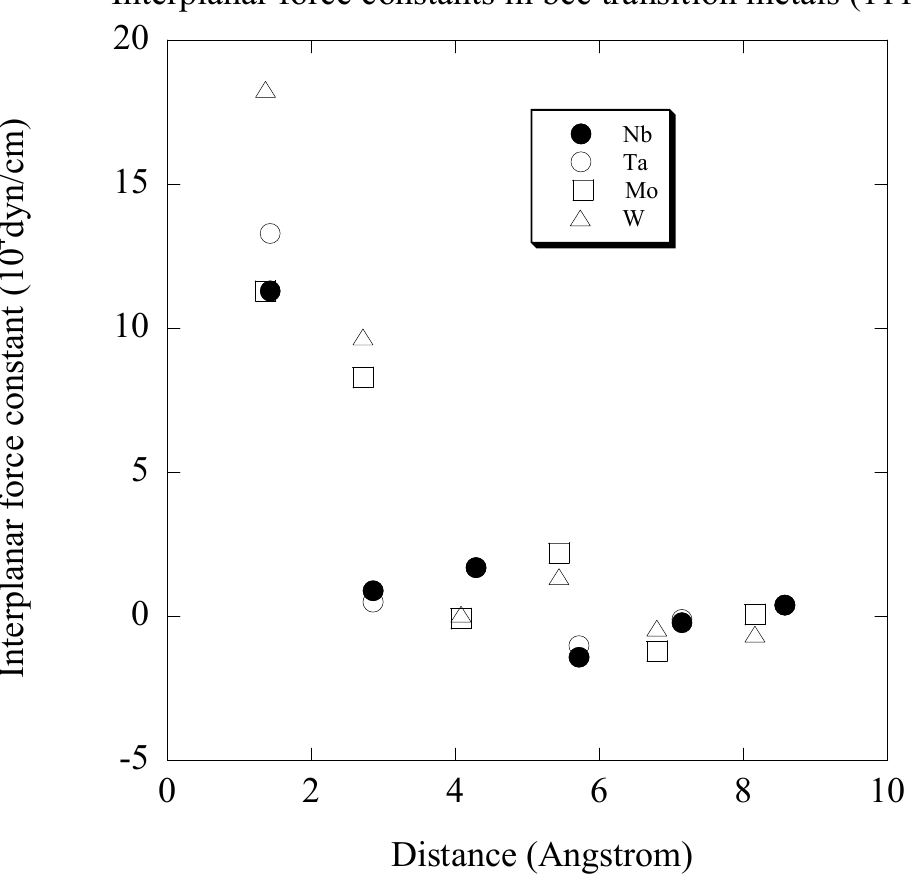
Figure 32. Interplanar force constants (10 4 dyncm − 1 ) for the body-centered cubic transition metals niobium, molybdenum, tantalum, and tungsten derived from the [ ζζζ ] T modes. The data for this figure were taken from Table 1 of ref. [84] courtesy of the